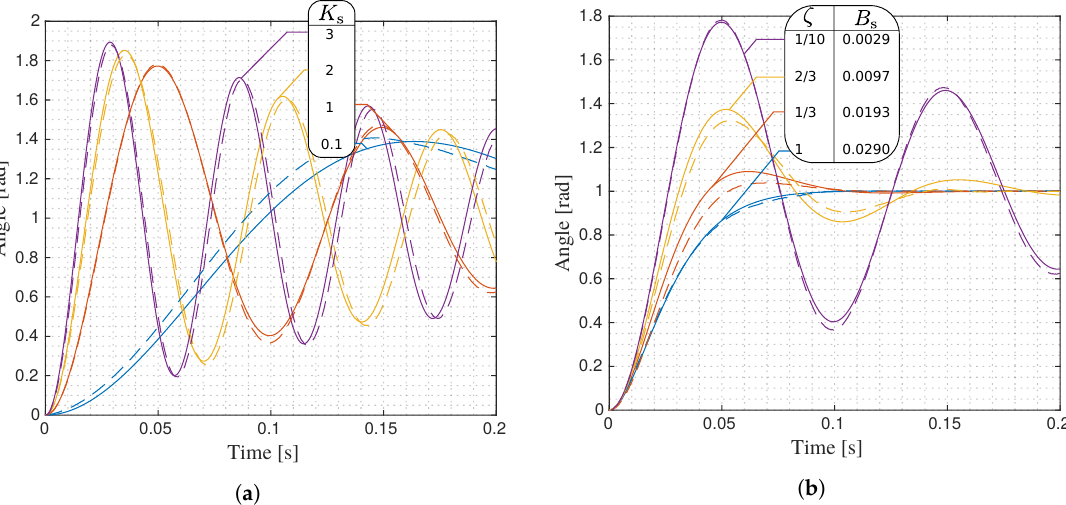
Figure 10. Measured (dashed lines) and simulated (solid lines) results from eight experiments (listed in Table A2) conducted on the active impedance controller. The spring constant is varied in ( a ) and the damping constant is varied in ( b ). The measured results are offset and scaled to match the amplitude and start angle of the